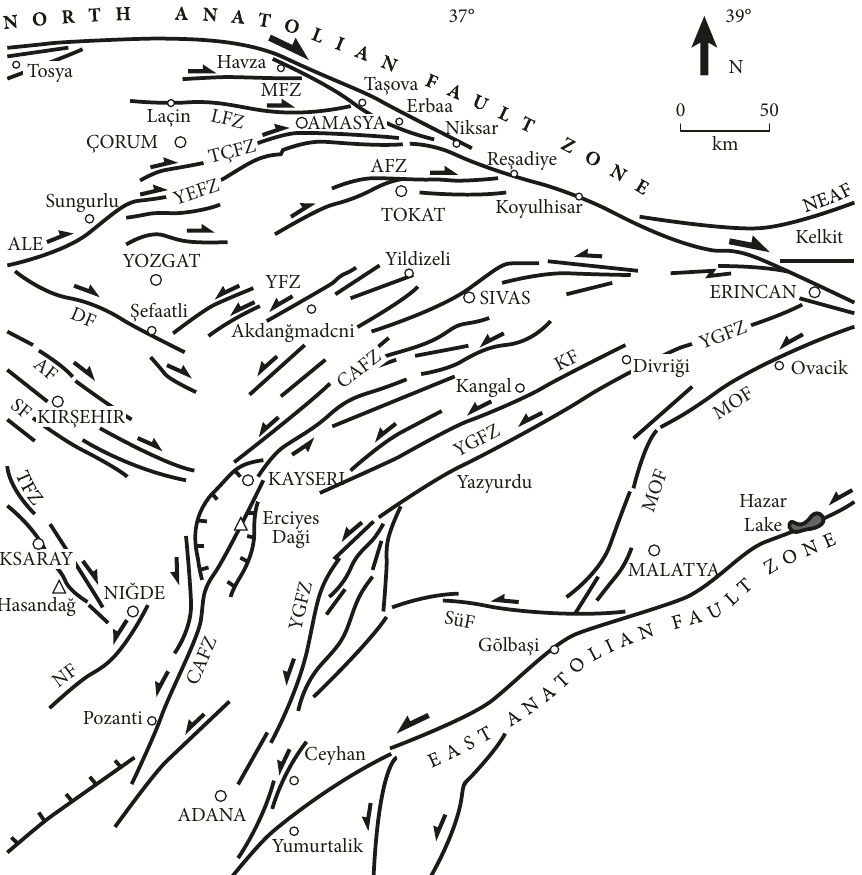
Figure 2: Simplified map showing major structural elements of east central Anatolia [39].